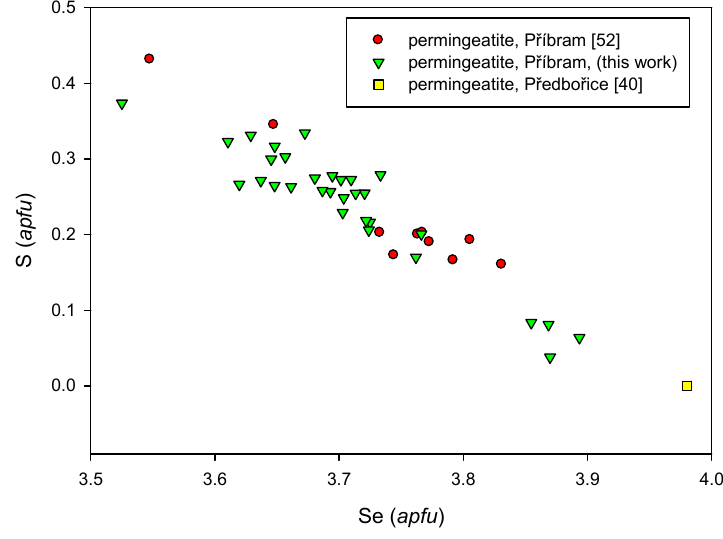
Figure 44. Se vs. S ( apfu ) graph for permingeatite.